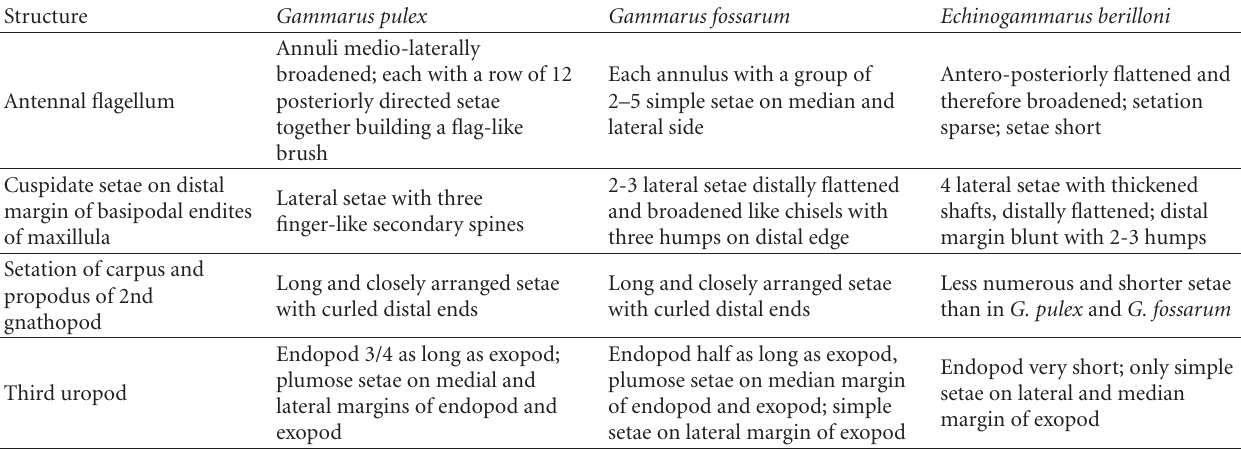
Table 1: Main di ff erences in morphology of mouthparts and other structures involved in food acquisition.